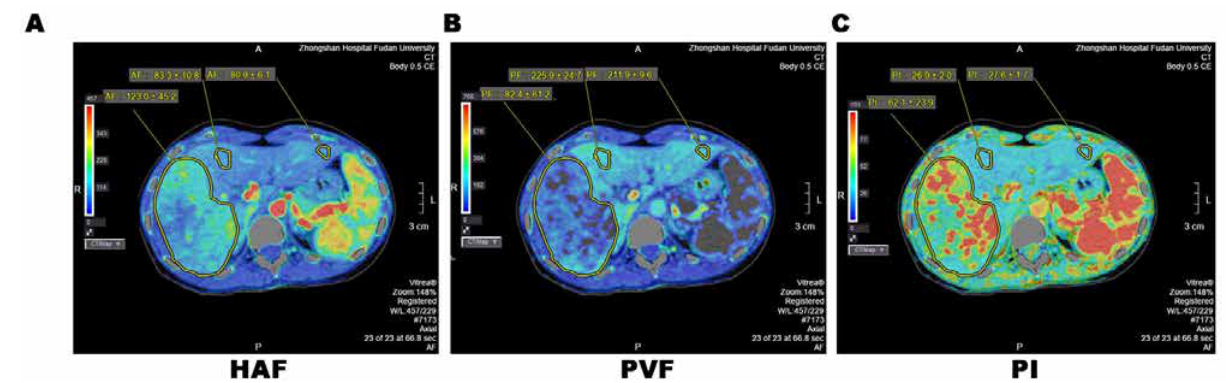
Figure 2 : A 37-year-women was diagnosed as advanced HCC. A to C, Liver perfusion CT maps of HAF, PVF, and PI, respectively. The